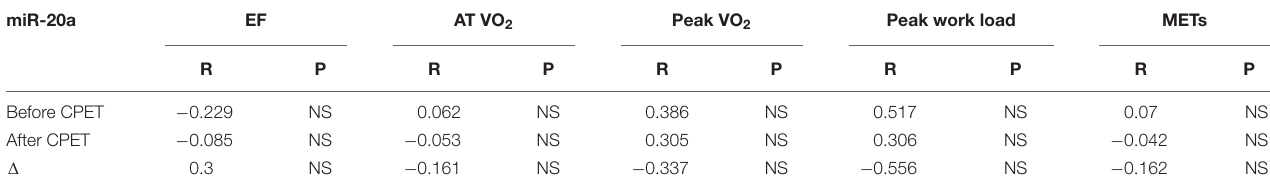
FIGURE 3 | Correlation analysis between the changes of miR-20a following CPET and cardiac function(EF%), exercise capacity (AT VO 2 , peak VO 2 , peak work load, METs) at baseline. TABLE 4 | Correlation analysis between miRNA changes following CPET and cardiopulmonary function indexes. miR-20a EF AT VO 2 Peak VO 2 Peak work